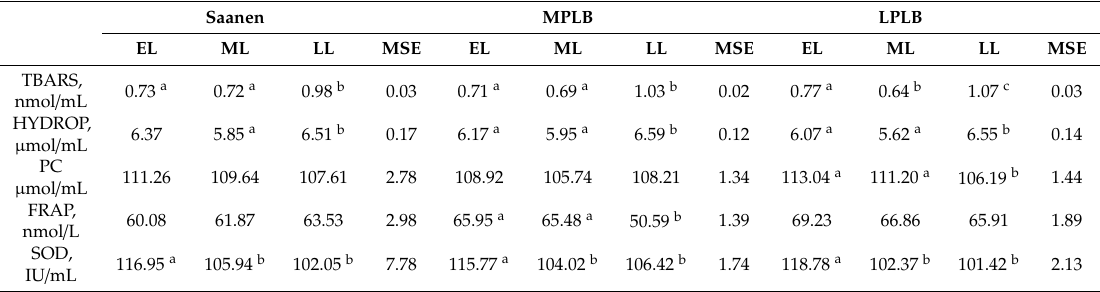
Table 7. E ff ect of the stage of lactation (early lactation, EL, 2–4 weeks in milking; medium lactation, ML, 5–10 weeks in milking; and late lactation, LL, 11–30 weeks) on the plasma oxidative profile of Saanen breed, Mediterranean medium production level breeds (MPLB: Maltese and Jonica breeds), and low production level breeds (LPLB: Rossa Mediterranea, Girgentana, and Garganica breeds). Saanen MPLB LPLB EL ML LL MSE EL ML LL MSE EL ML LL MSE TBARS, 0.73 nmol / mL